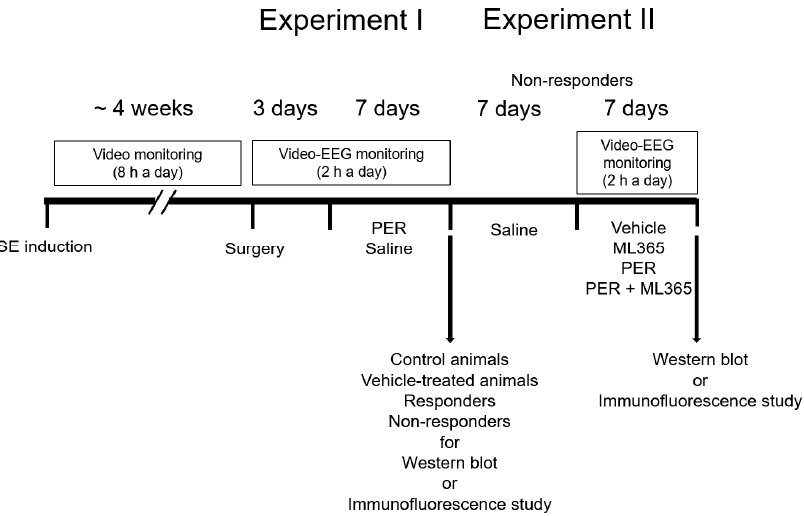
Figure 2. Scheme of the experimental design in the present study. After responders and non-re- sponders were selected, they were used for Western blot or immunofluorescence studies together with control (normal) and vehicle-treated epilepsy rats. Some non-responders were intracerebro- ventricularly infused with vehicle or ML365. Some animals in this group were also daily given ve- hicle or PER. After recording, animals were used for Western blot or immunofluorescence studies. Abbreviation: EEG, electroencephalogram; ML365, a specific TASK-1 inhibitor; PER, perampanel; SE, status